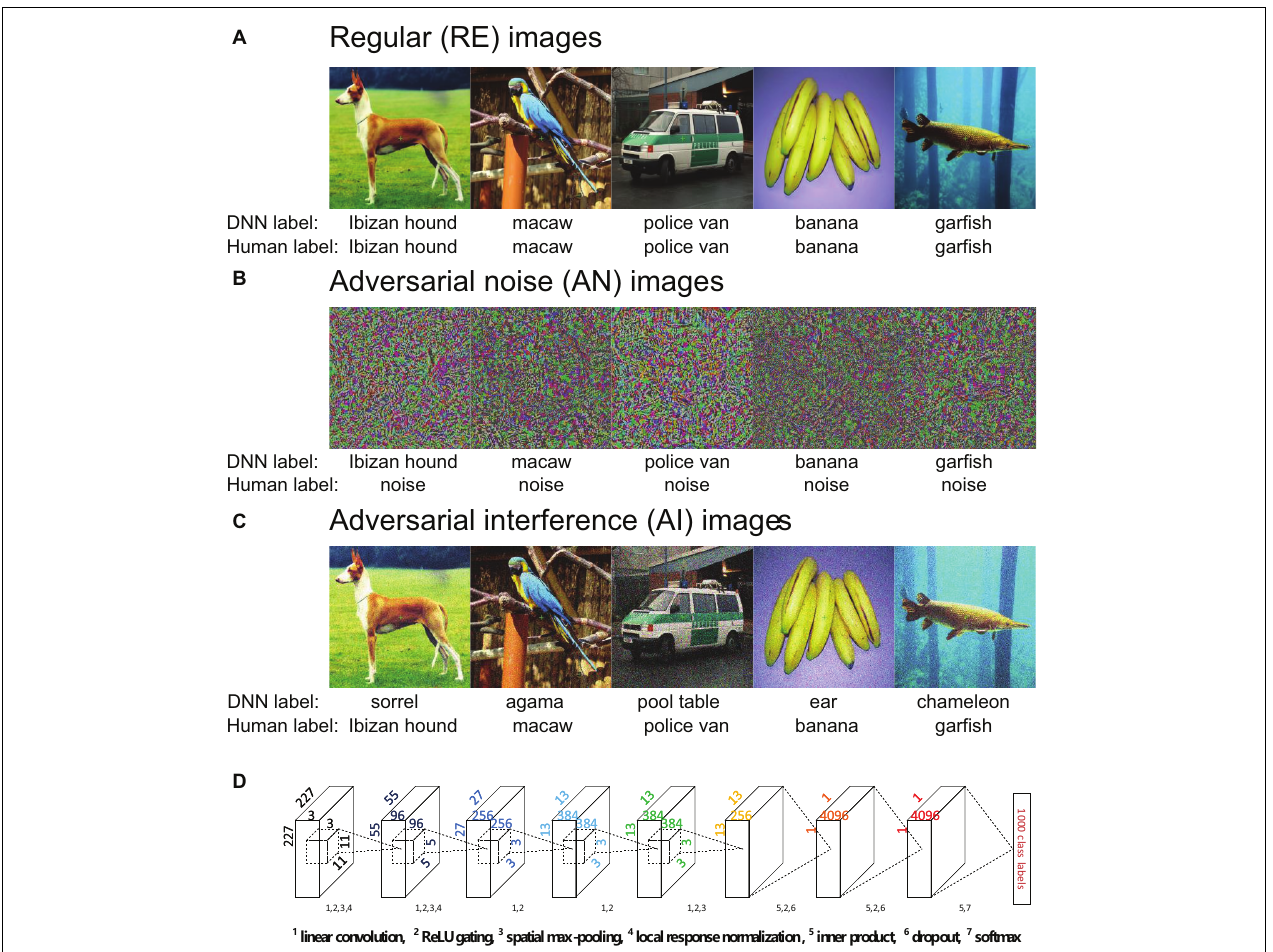
FIGURE 1 | (A–C) Example regular (RE, panel A ), adversarial noise (AN, panel B ) images and adversarial interference (AI, panel C ) images. The five AN and five AI images one-by-one correspond to the five RE images. The labels provided by AlexNet and humans are listed under the images. The AI images contain a small amount of special image noise but overall look similar to the corresponding RE images. Humans can easily recognize the AI images as corresponding categories but the AN images as noise. AlexNet can classify the AN images into corresponding categories with over 99% confidence, but recognize the AI images as wrong categories. (D) The architecture of AlexNet. Details have been documented in Krizhevsky et al. (2012). Each layer uses some or all the following operations: linear convolution, ReLU gating, spatial max-pooling, local response normalization, inner product, dropout and